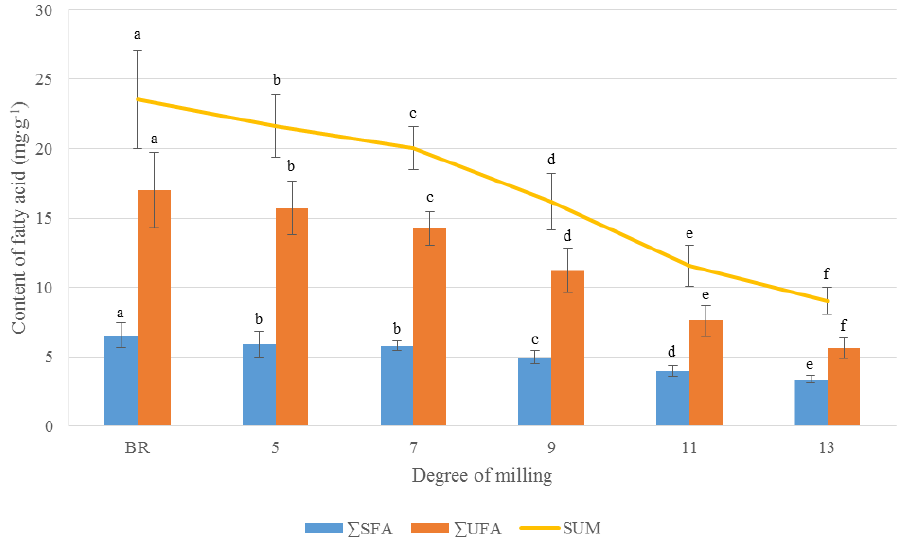
Figure 3. Comparison of the total FA, unsaturated (U)FA, and saturated (S)FA content of rice grains according to the DOM. Different superscripts (a–f) represent a significant difference in the FA content of rice, depending on the DOM ( p < 0.05).